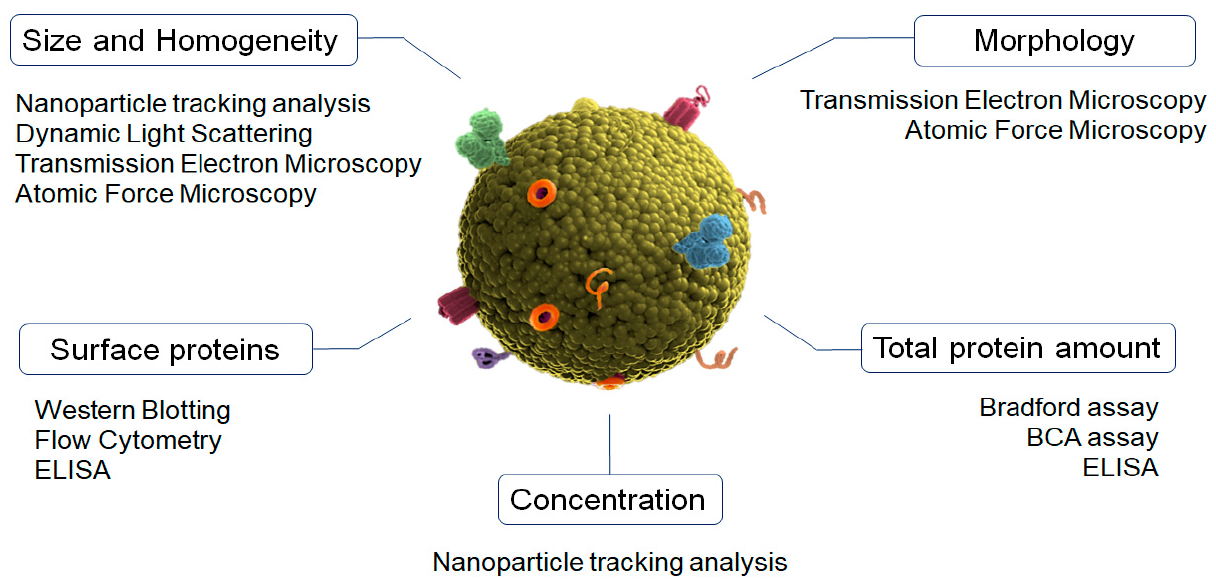
Figure 1. Characterization methods of exosomes main physicochemical properties.